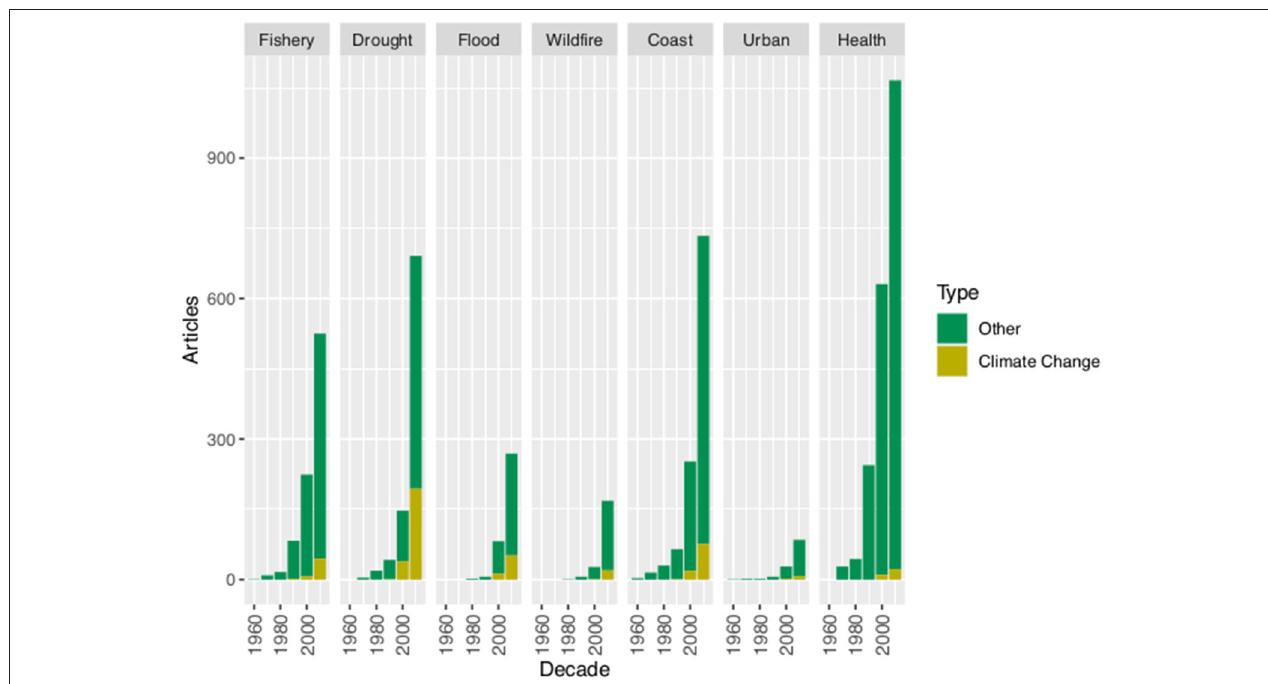
FIGURE 2 | Number of journal articles (per decade) on decision-making and risk management found in the literature database SCOPUS in each decade for seven climate-related risks, with the number specifically related to “climate change” indicated. Journal Articles were found by searching abstracts using the search “ABS ({risk assessment} OR {risk management} OR {decision making} OR {control system} OR {decision system}) AND (risk)”, where the risk was Fishery (extended search term – “fishery OR fisheries”), Drought (“drought”), Flood (“flood management OR flood mitigation”), Wildfire (“wildfire OR wild fire”), Coast (“coast”), Urban (“urban environment”), or Health (“public